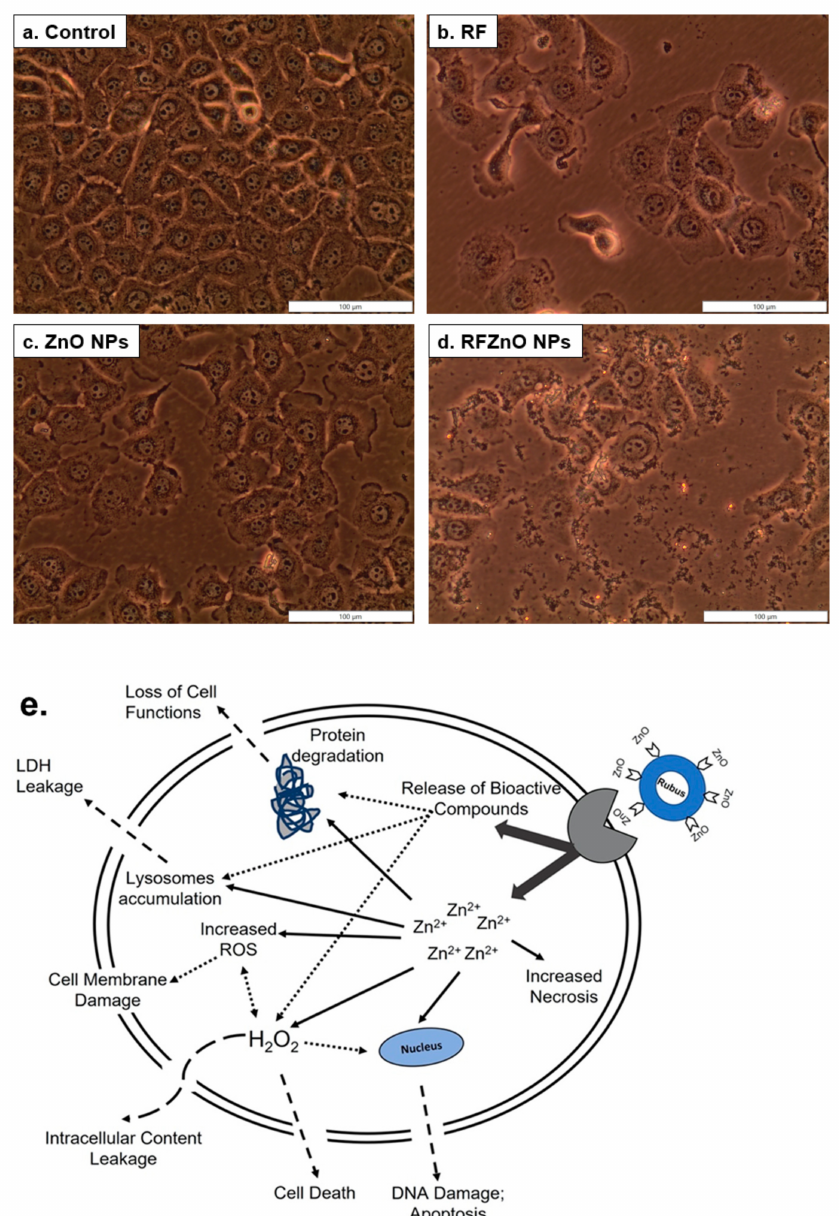
Figure 1. Morphological changes in MCF-7 breast cancer cells 24 h after treatment with Rubus fairholmianus (RF 10 µ g/mL), zinc oxide nanoparticles (ZnO NPs 10 µ g/mL), and R. fairholmianus capped zinc oxide nanoparticles (RFZnO NPs 10 µ g/mL). Control cells did not show any sign of cell death and were found to be healthy and confluent ( a ). Treated groups showed more dead cells with loss of membrane integrity. An increased number of dead cells was seen in RF ( b ) and RFZnO NP ( d ) treatment groups compared to the control group ( a ) and cells treated with ZnO NP ( c ). ( e ) Possible cell death/cytotoxicity mechanism of action induced by RFZnO